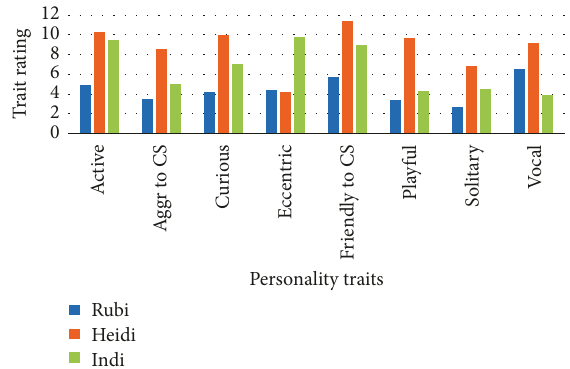
Figure 11: Personality profiles compiled from both keeper question- naires and observation data for each female. Aggr = Aggressive, CS = Conspecific.